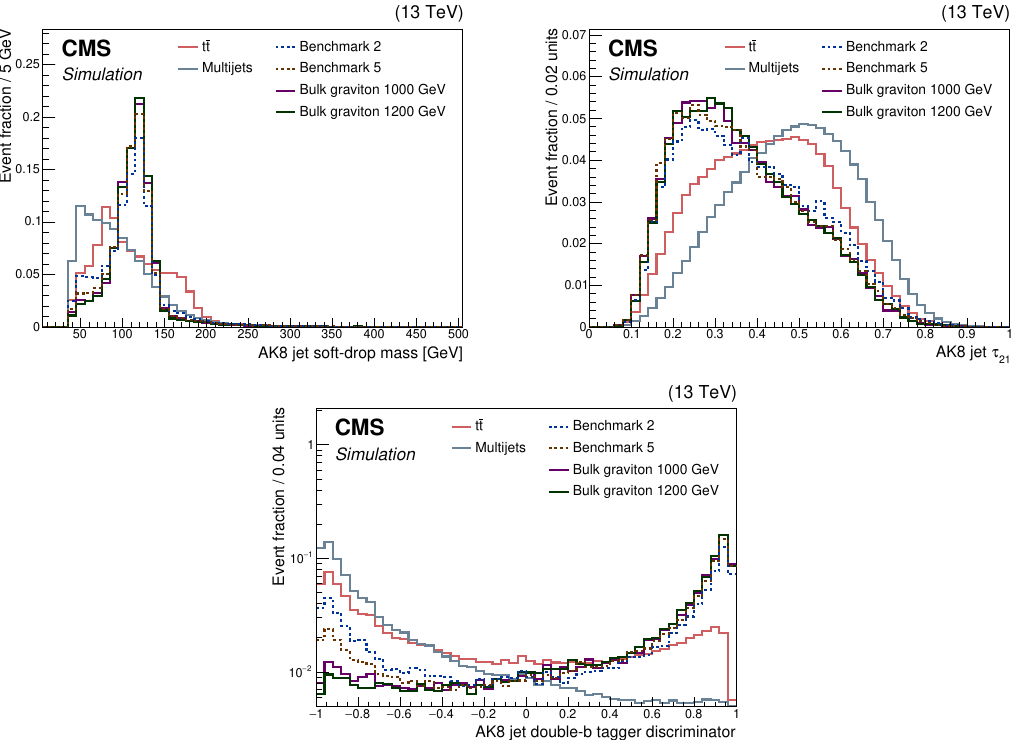
Figure 1 . Distributions of the soft-drop mass (upper left), (cid:28) 21 (upper right), and the double- b tagger (lower), for AK8 jets in semi-resolved events. The multijet and the tt+jets background components are shown separately, along with the simulated signals for bulk gravitons of masses 1000 and 1200 GeV and the non-resonant benchmark models 2 and 5. The distributions are normalized to